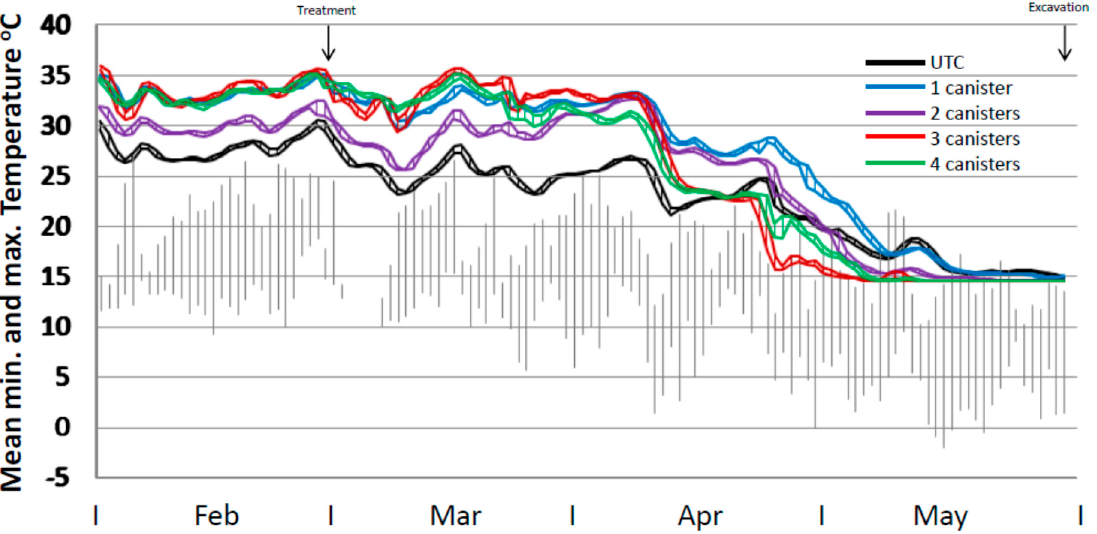
Figure 4. Internal temperature profile of mounds (mean minimum to maximum range) for untreated mounds ( n = 10), and mounds treated with one ( n = 5), two ( n = 4), three ( n = 5) or four ( n = 5) 120 g canisters. Ambient temperature ranges from the closest weather station are shown in grey. Note. Temperature probes had a lower limit of 14.5 °C.